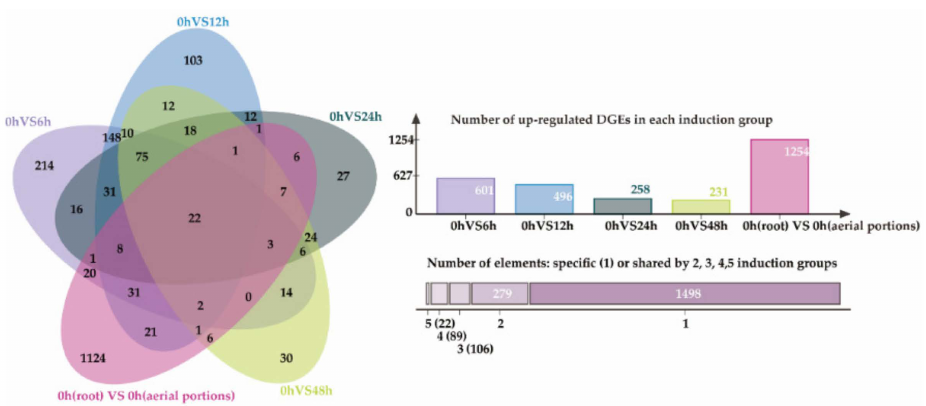
Figure 2. Venn diagram of up-regulated DEGs by different induction groups in the A. gymnandrum